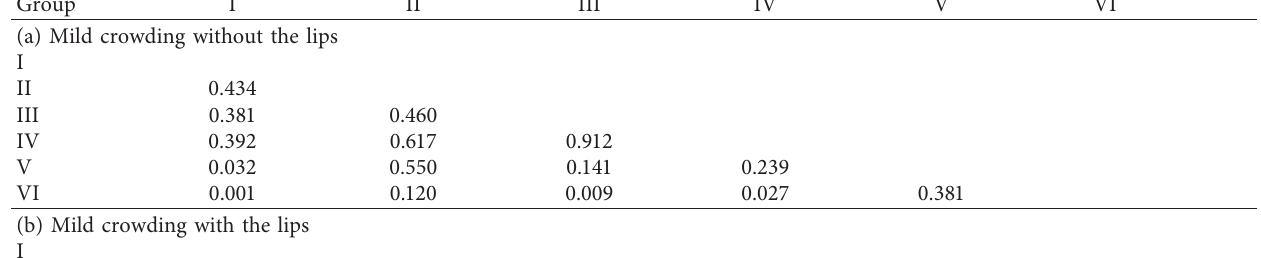
Table 3: Differences among groups in the perception of attractiveness of anterior crowding with and without the lips.